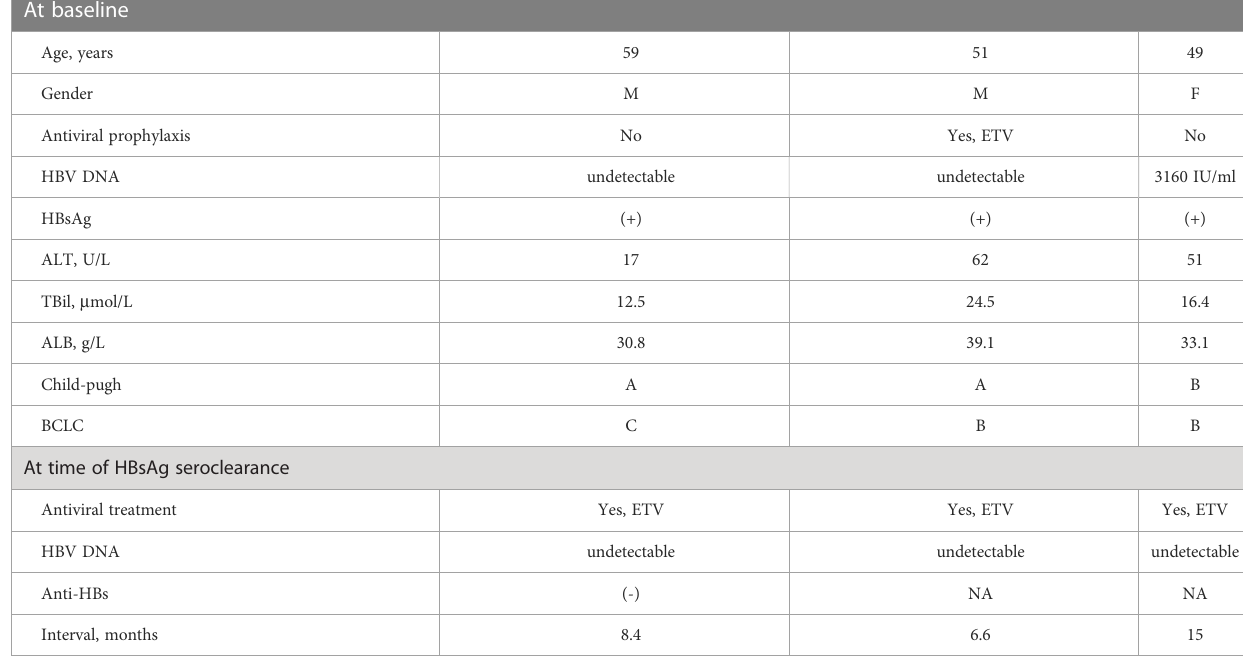
TABLE 3 Clinical characteristics of 3 patient who achieved HBsAg seroclearance.